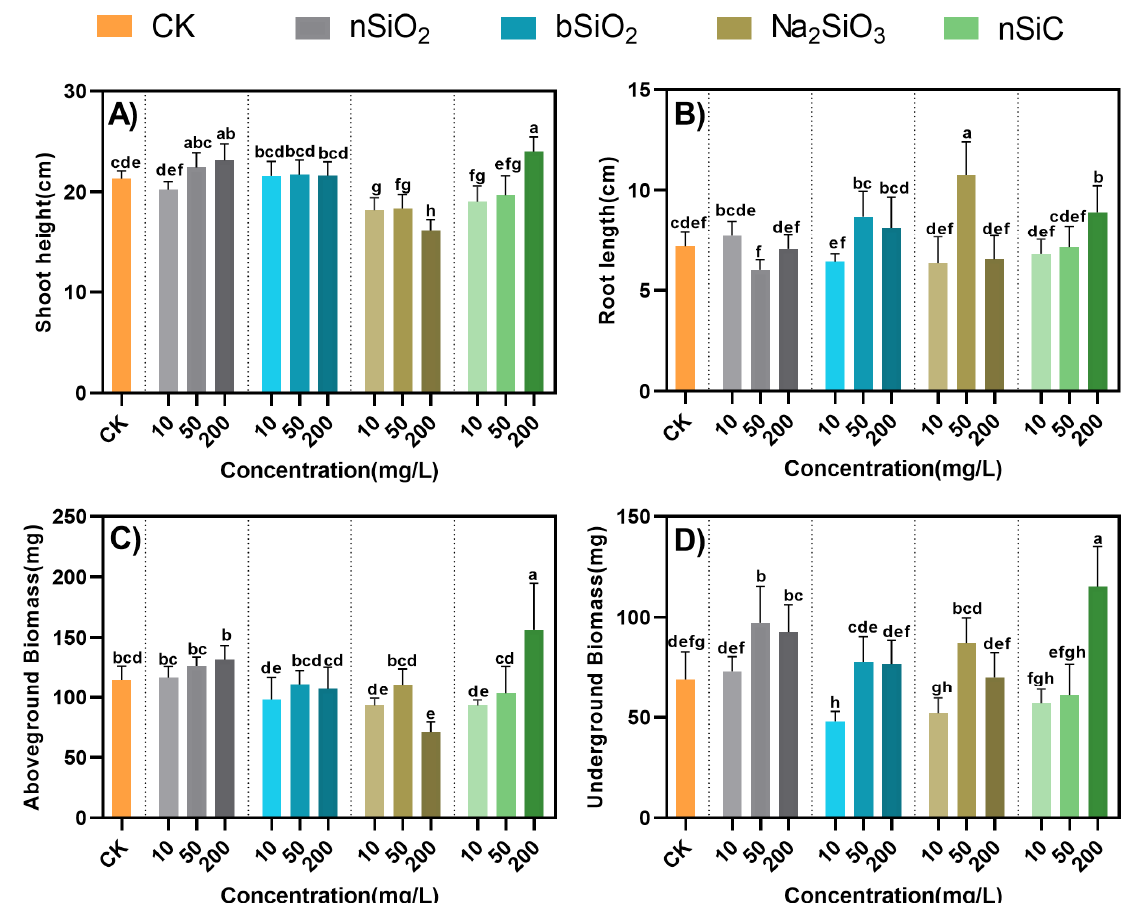
Figure 2. Effects of Si-based NMs on rice growth and development. ( A ) Shoot height; ( B ) Root length; ( C ) Aboveground biomass; ( D ) Underground biomass. Columns marked with the same letter were not significantly different at p < 0.05 ( n = 4).